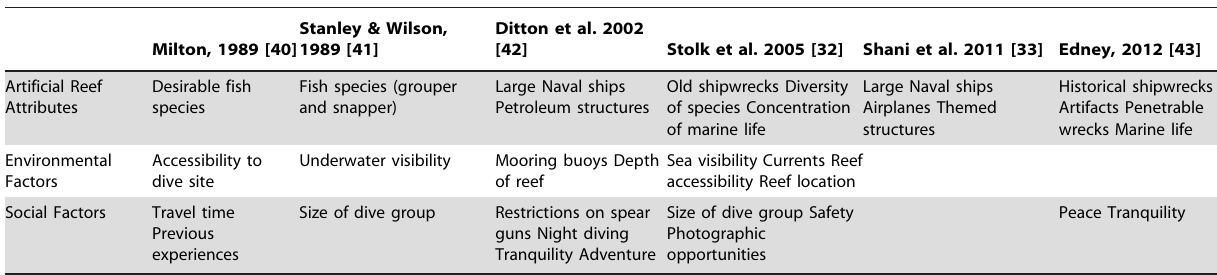
Table 1. Previous studies and key findings of motivational factors related to diving on artificial reefs.